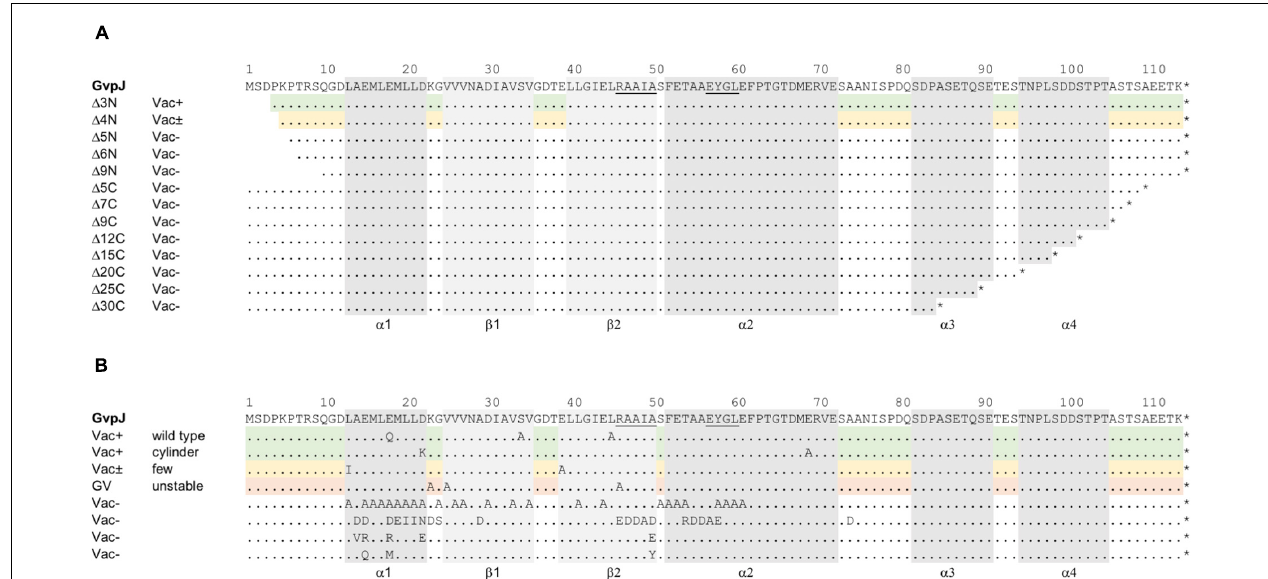
FIGURE 1 | Mutations in the accessory protein GvpJ. The aa sequence of GvpJ is given on top with the α -helices shaded in gray; the β -sheets are shaded in light gray. These structural features are marked below. Dots indicate identical aa residues. The RAAIA and EYGL motifs are underlined. (A) Deletions introduced in GvpJ. Each line represents a deletion variant, and the Vac phenotype is given on the left. Green shades highlight Vac + and yellow shades Vac ± transformants. (B) Summary of the single aa substitutions leading to a Vac + , Vac ± , or Vac − phenotype. Each letter represents a single aa substitution in GvpJ. Different substitutions are arranged according to the Vac phenotype. The Vac + phenotype is divided in gas vesicle of wild-type or cylinder shape (shaded in green). The line containing single substitutions in GvpJ yielding Vac ± (cid:49) J + J mut transformants is shaded in yellow, and the line with alterations yielding unstable gas vesicles is shaded in